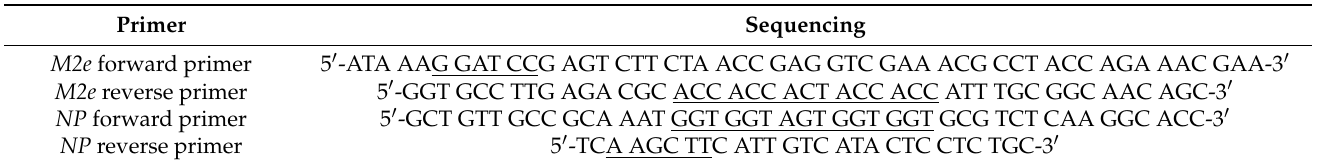
Table 1. Primer sequences used for the amplification of the influenza M2e and NP genes.